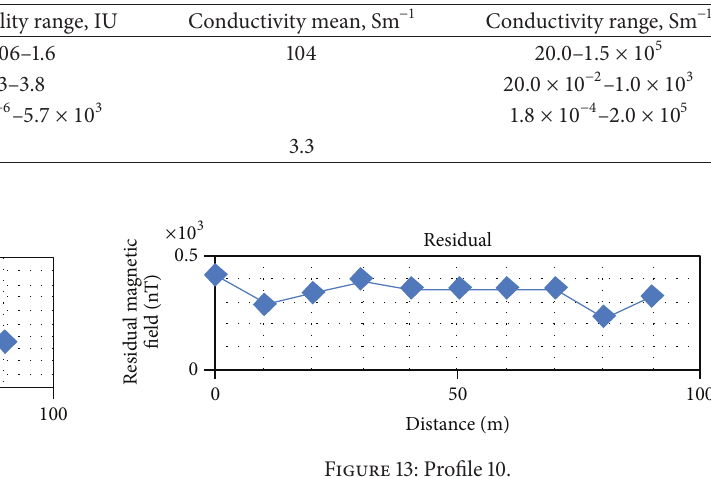
Figure 11: Profile 8.